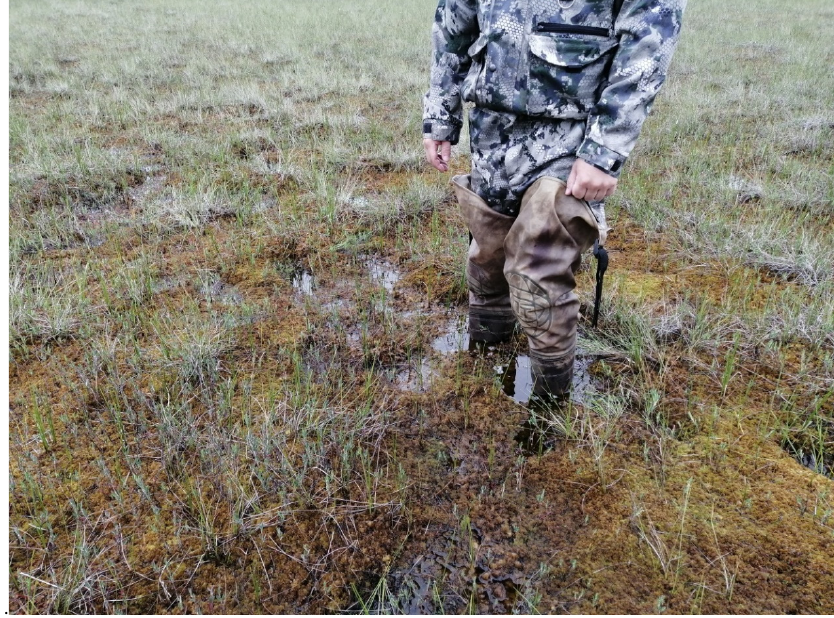
Figure A3. The peat bog is characterized by strong watering, which is typical on the peatlands of European Subarctic of Russia.